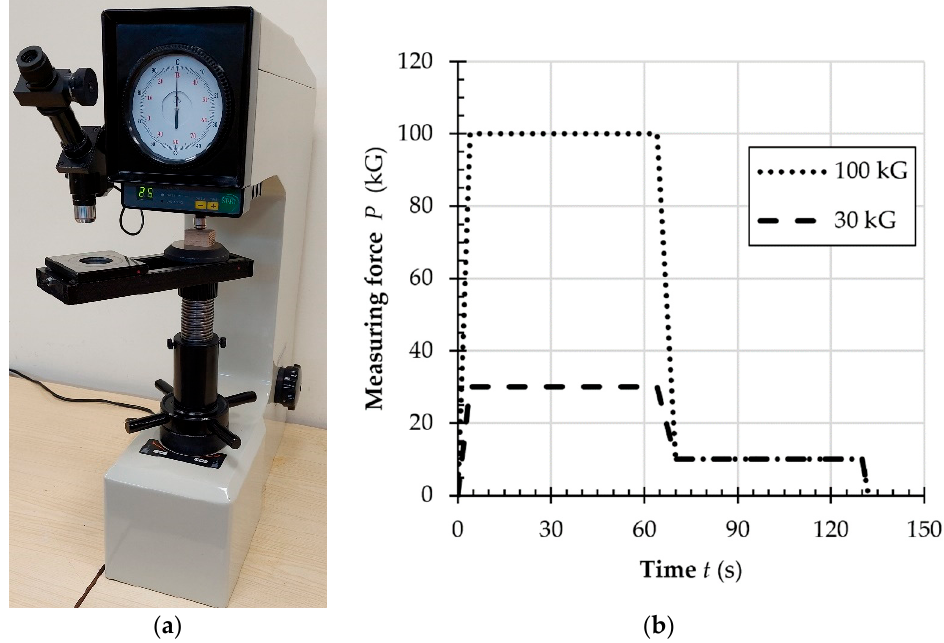
Figure 2. Hardness tester and measuring force: ( a )—HBRV-187.5E Brinell hardness tester (Huatec, Beijing, China), ( b )—force exertion modes.